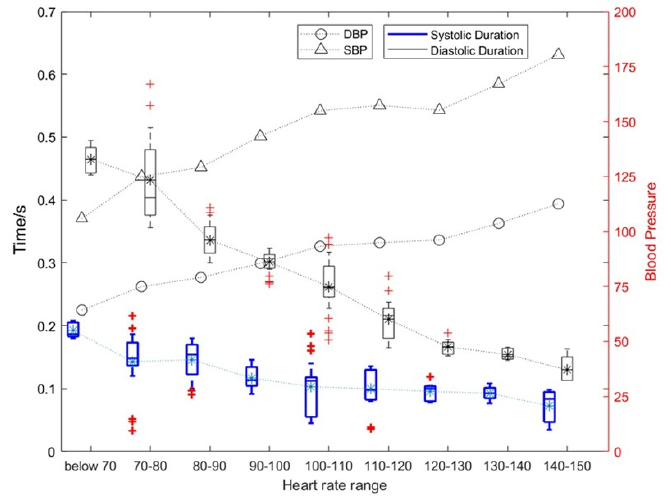
Figure 7. The influence of heart rate changes on the duration of diastolic and systolic periods and the corresponding blood pressure change rules.